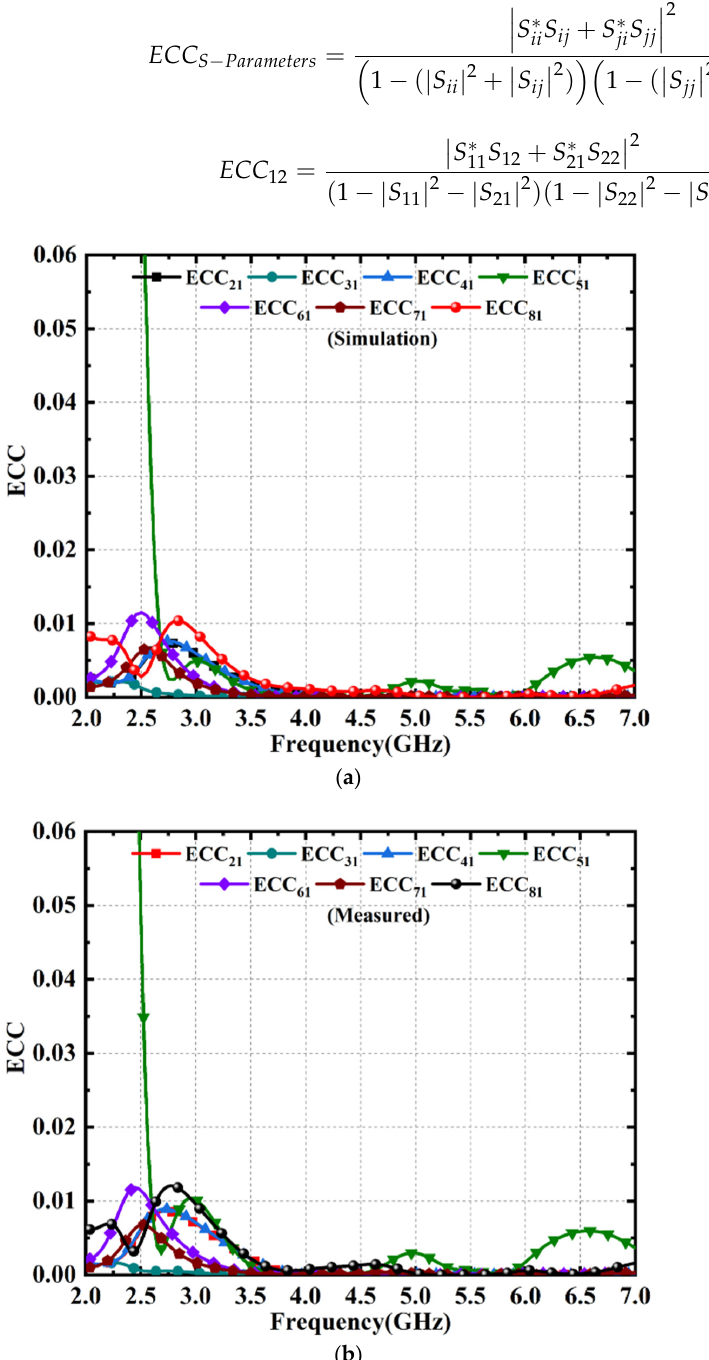
Figure 15. ECC response: ( a ) simulation and ( b ) measured.